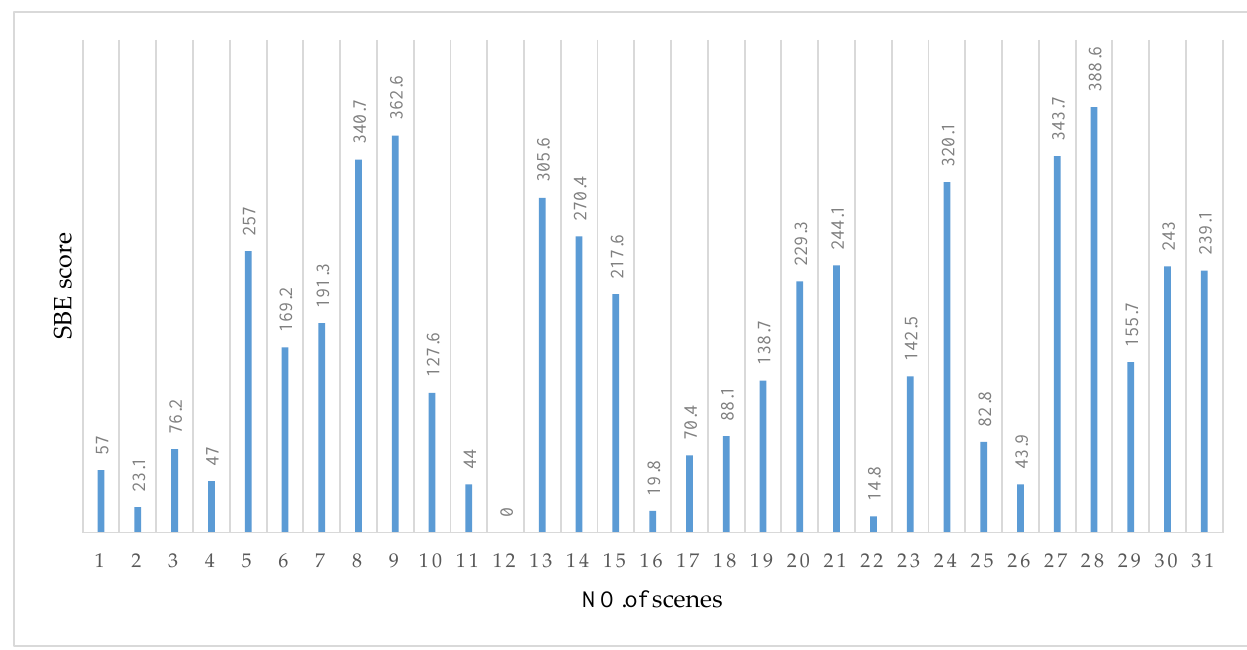
Figure 5. SBE score of each scene.